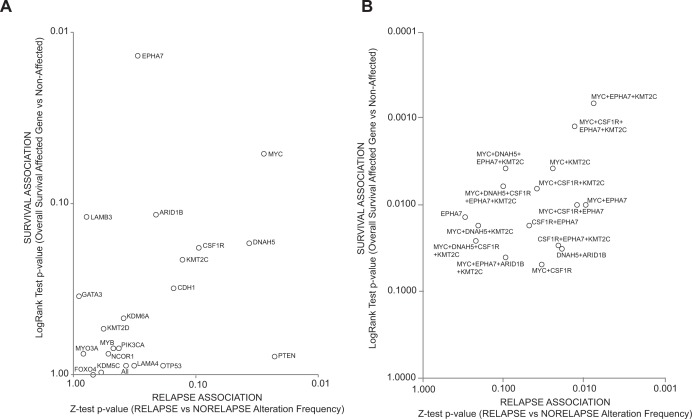
Candidate genes and signatures for prognostic testing.(A) Candidate genes ranked according to their association with relapse (X axis) and survival (Y axis) in the TCGA series. A smaller p-value in both axes (top-right of the scatterplot) indicates greater association between the query gene and the associated variables. (B) Candidate signatures ranked as in (A). Only the signatures with overall survival log-rank test p<0.05 are represented.